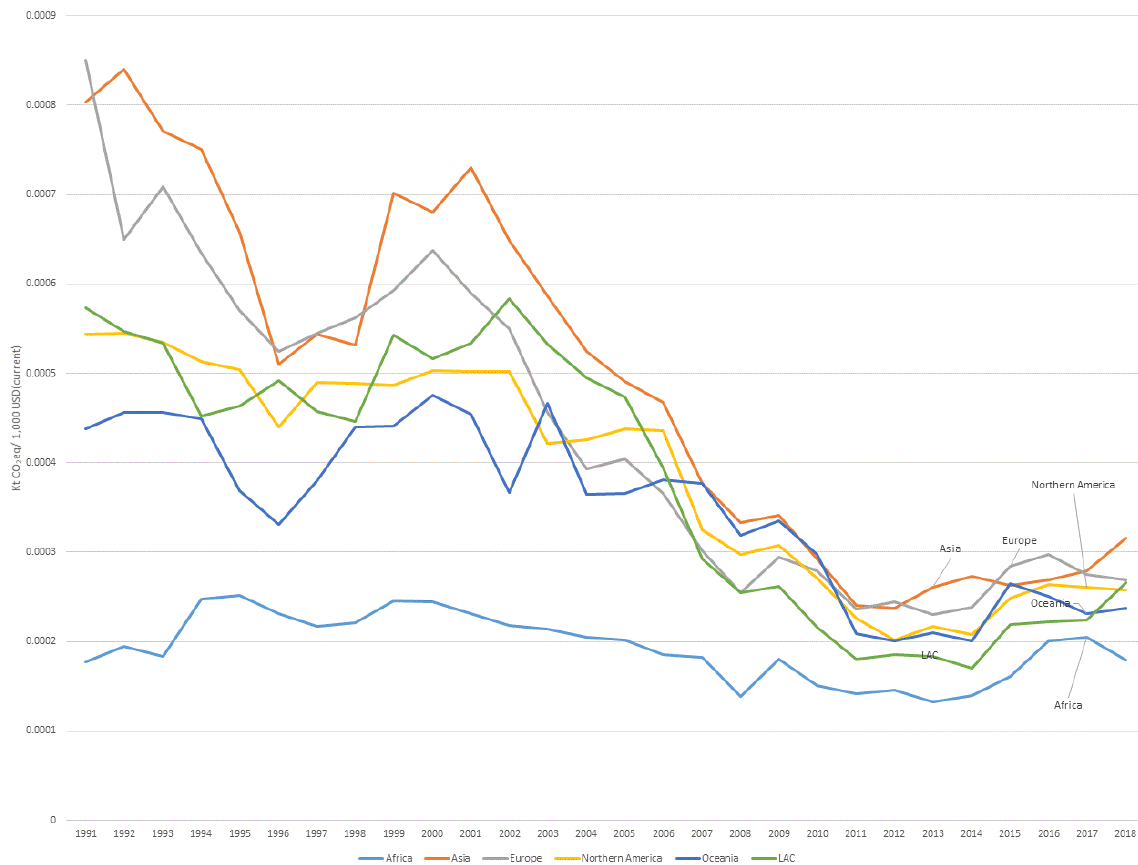
Figure 5. GHG emission from energy use in agriculture per gross agriculture production value in 1991–2018 (KtCO 2 eq/current USD1000). Source: FAOSTAT, based on data from IEA and UNSD